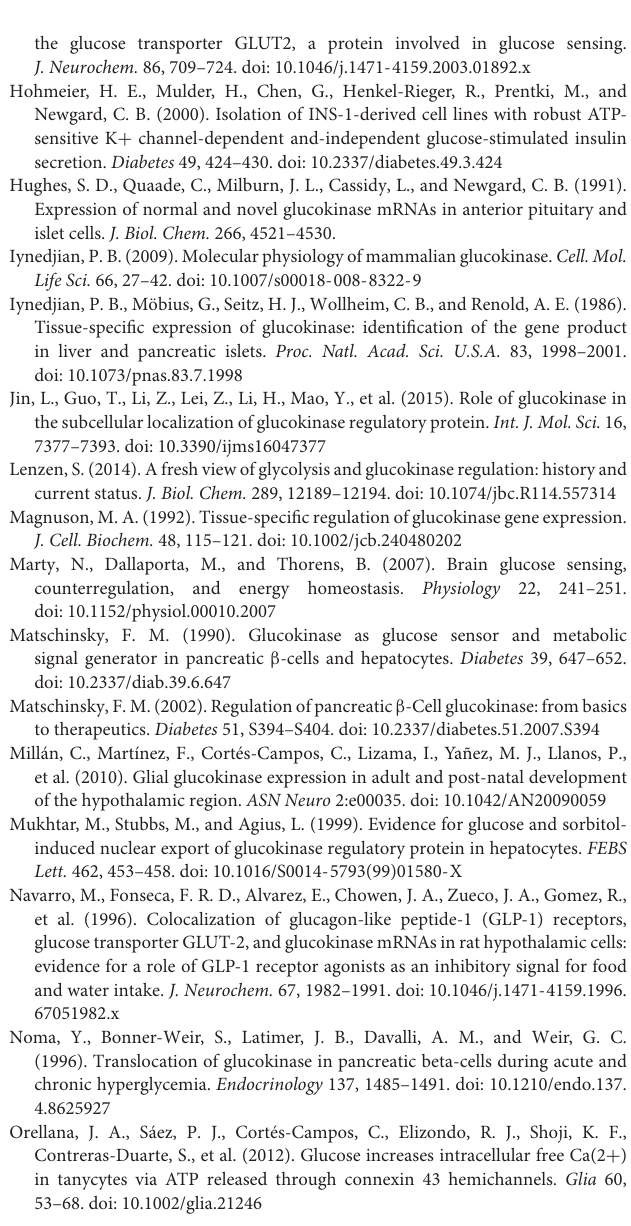
to 0.5 mM glucose for 30 min. (A) Dynamic subcellular localization of GKRP through fluorescence detection of RFP. (B) Dynamic subcellular localization of GK through immunocytochemistry. Scale Bar 20 µ m. (C,D) Quantification of nuclear/cytoplasmic ratio measured by fluorescence intensity of both subcellular compartments for GKRP (C) and GK (D) . Inserted box: Saccharose control treatments. Arrowheads are indicating the nucleus of insulinoma cells. FIGURE S4 | Downregulation of GKRP through shRNA. For downregulation, we constructed adenovirus that overexpress a shRNA for GKRP (Ad-shGKRP-EGFP) and a shRNA for β -galactosidase (Ad-sh β gal-EGFP). Transduced tanycytes were culture at 0.5 mM for 6 h with a posterior increased to 15 mM glucose for 30 min. (A–F) Subcellular localization of GK in cells cultured with 0.5 mM glucose and transduced with Ad-control (A–C) or Ad-shGKRP-EGFP (D–F) . (G–L) Subcellular localization of GK in cells cultured with 15 mM glucose and transduced with Ad-control (G–I) or Ad-shGKRP-EGFP (J–L) . Nuclear localization of GK is lost at 15 mM glucose when GKRP is downregulated.